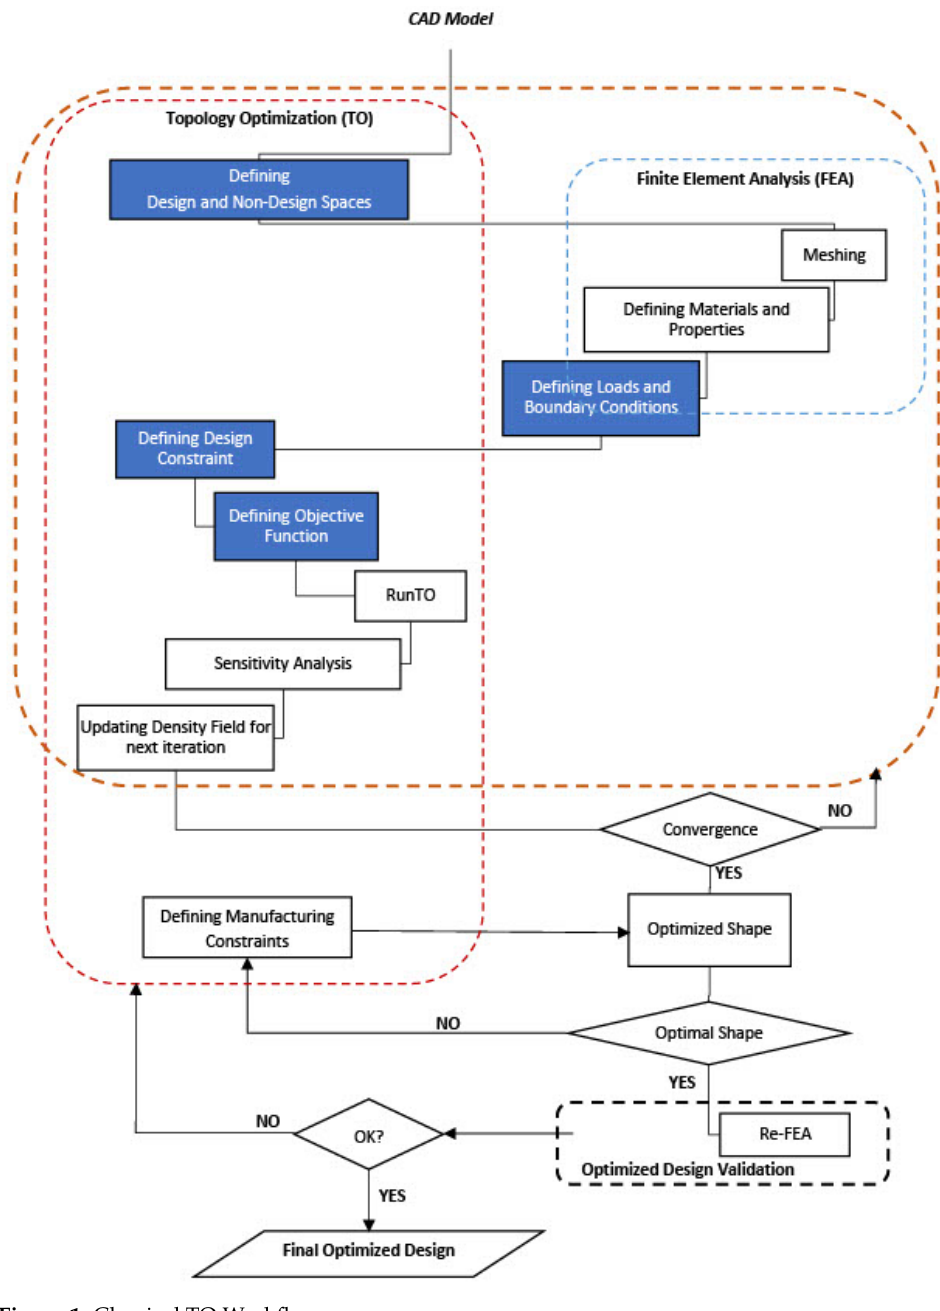
Figure 1. Classical TO Workflow.